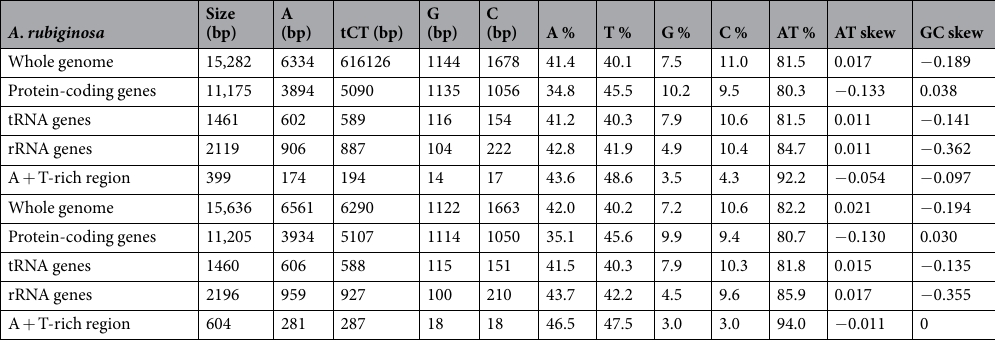
Table 4. Composition and skewness in the A . rubiginosa and R . menciana mt